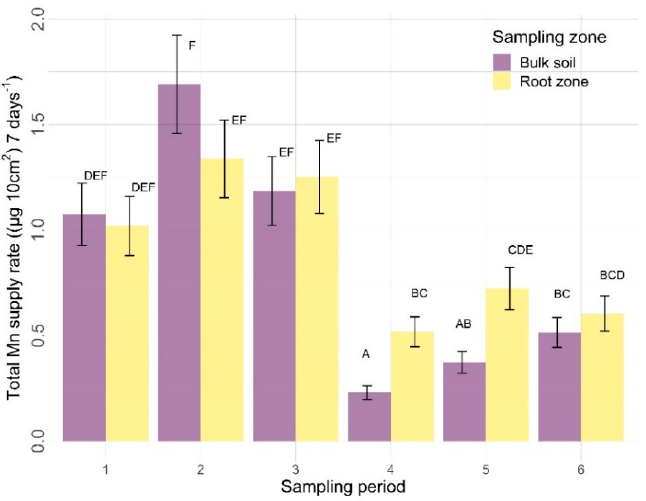
Figure 13. Mn supply rates as a function of sampling zone and time. Different letters indicate significance at p < 0.05 using the post hoc Tukey HSD test.